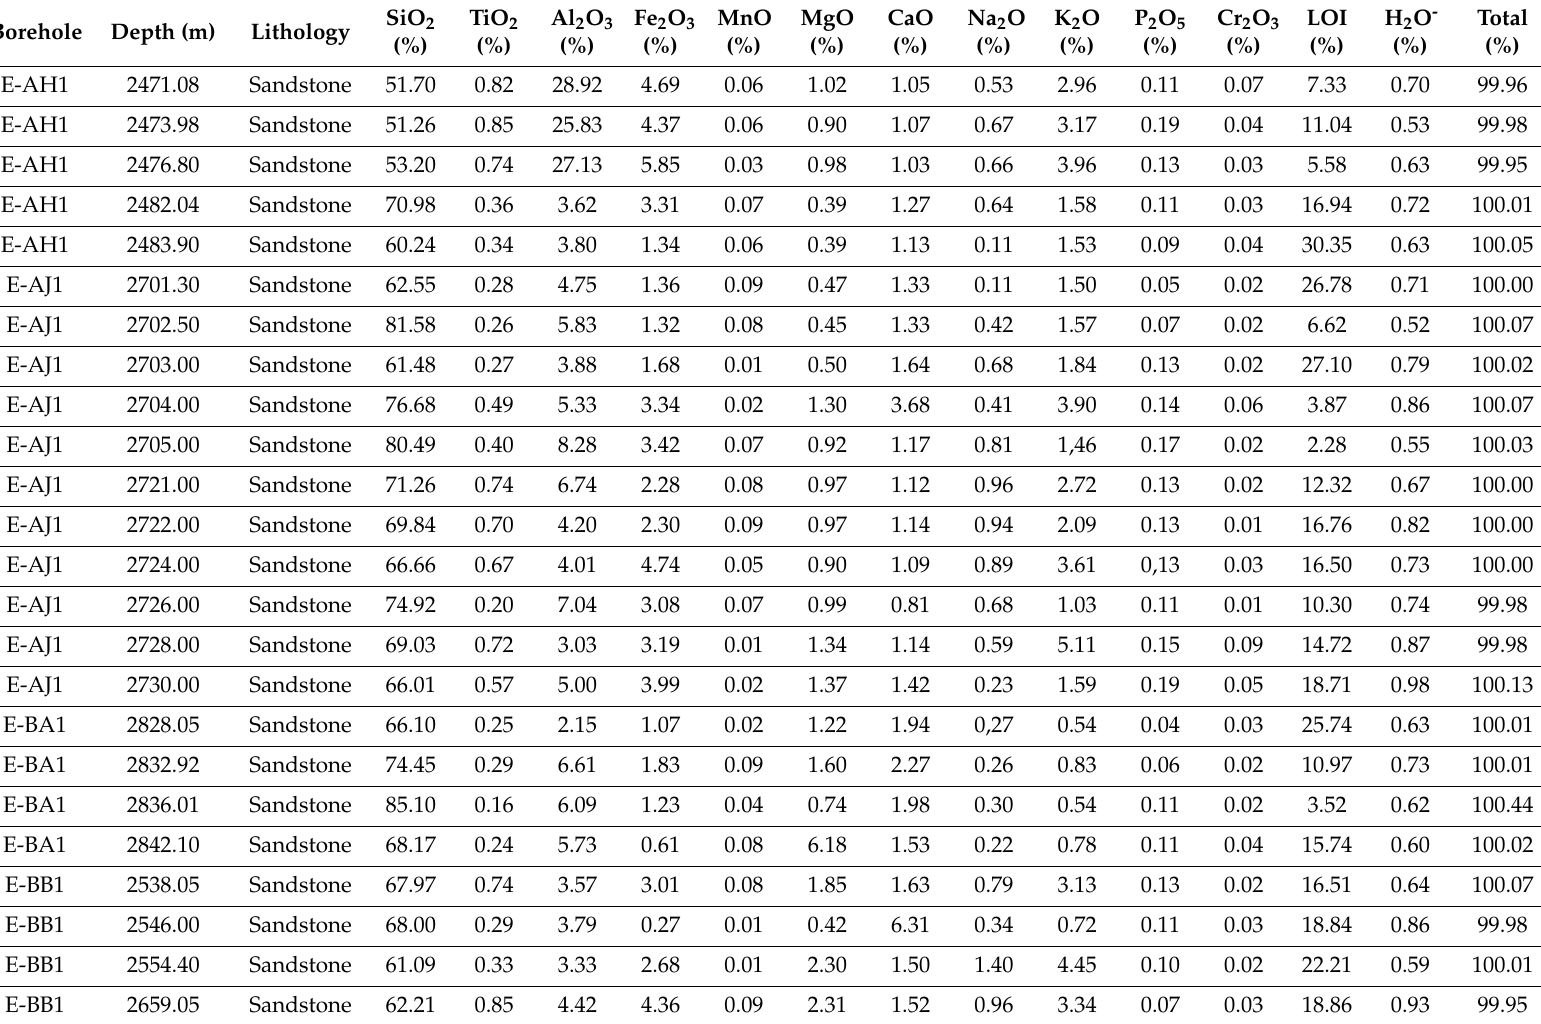
Table 4. Results of oxides (wt%) analysed by X-ray fluorescence